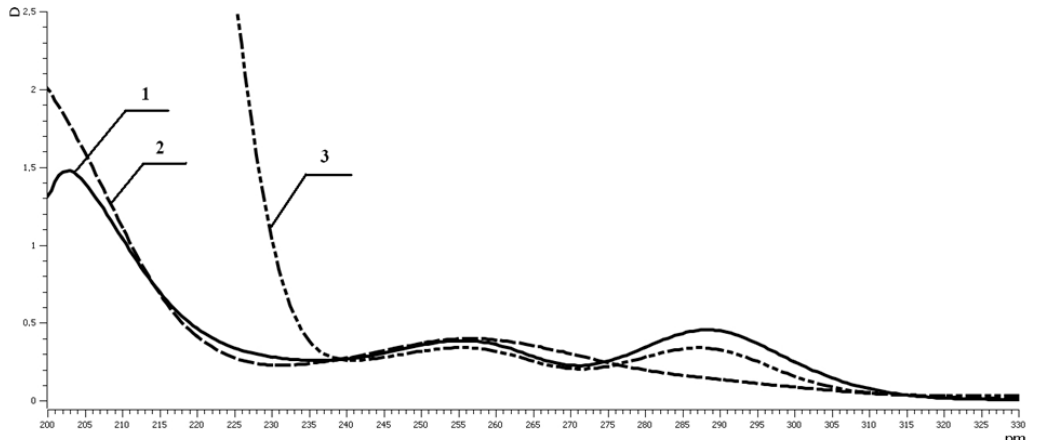
Figure 9. UV–vis spectra in PBS of 1—VP–VDTC; 2—VP–VDTC–Ga; 3—VP–VDTC–Ga with 20 molar excess of histidine.